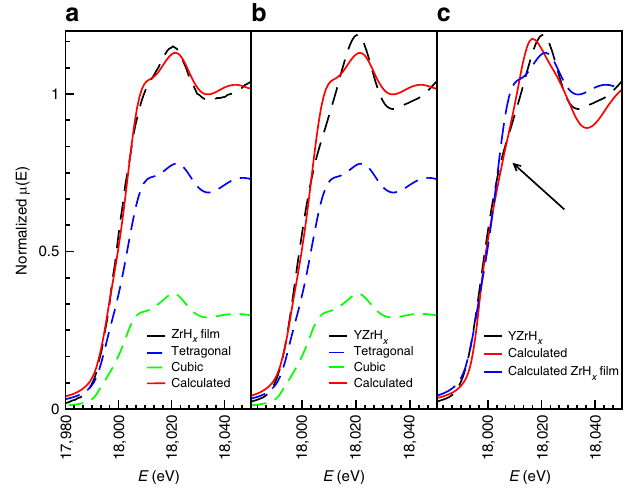
Fig. 4 XANES simulations performed on hydrogenated Zr and YZr thin fi lms. a ZrH x fi lm, b , c YZrH x thin fi lms. The arrow in c highlights the different position of the shoulder in the YZrH x sample, which cannot be reproduced by using either tetragonal or cubic phase